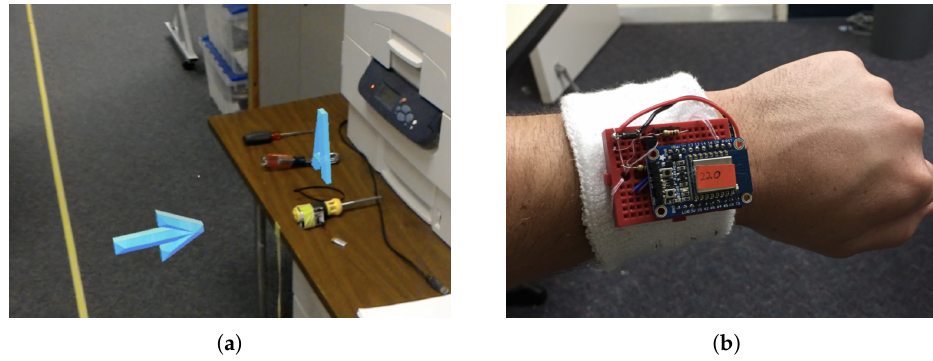
Figure 9. ( a ) HoloLens holographic overlays. ( b ) Wristband with ESP8266